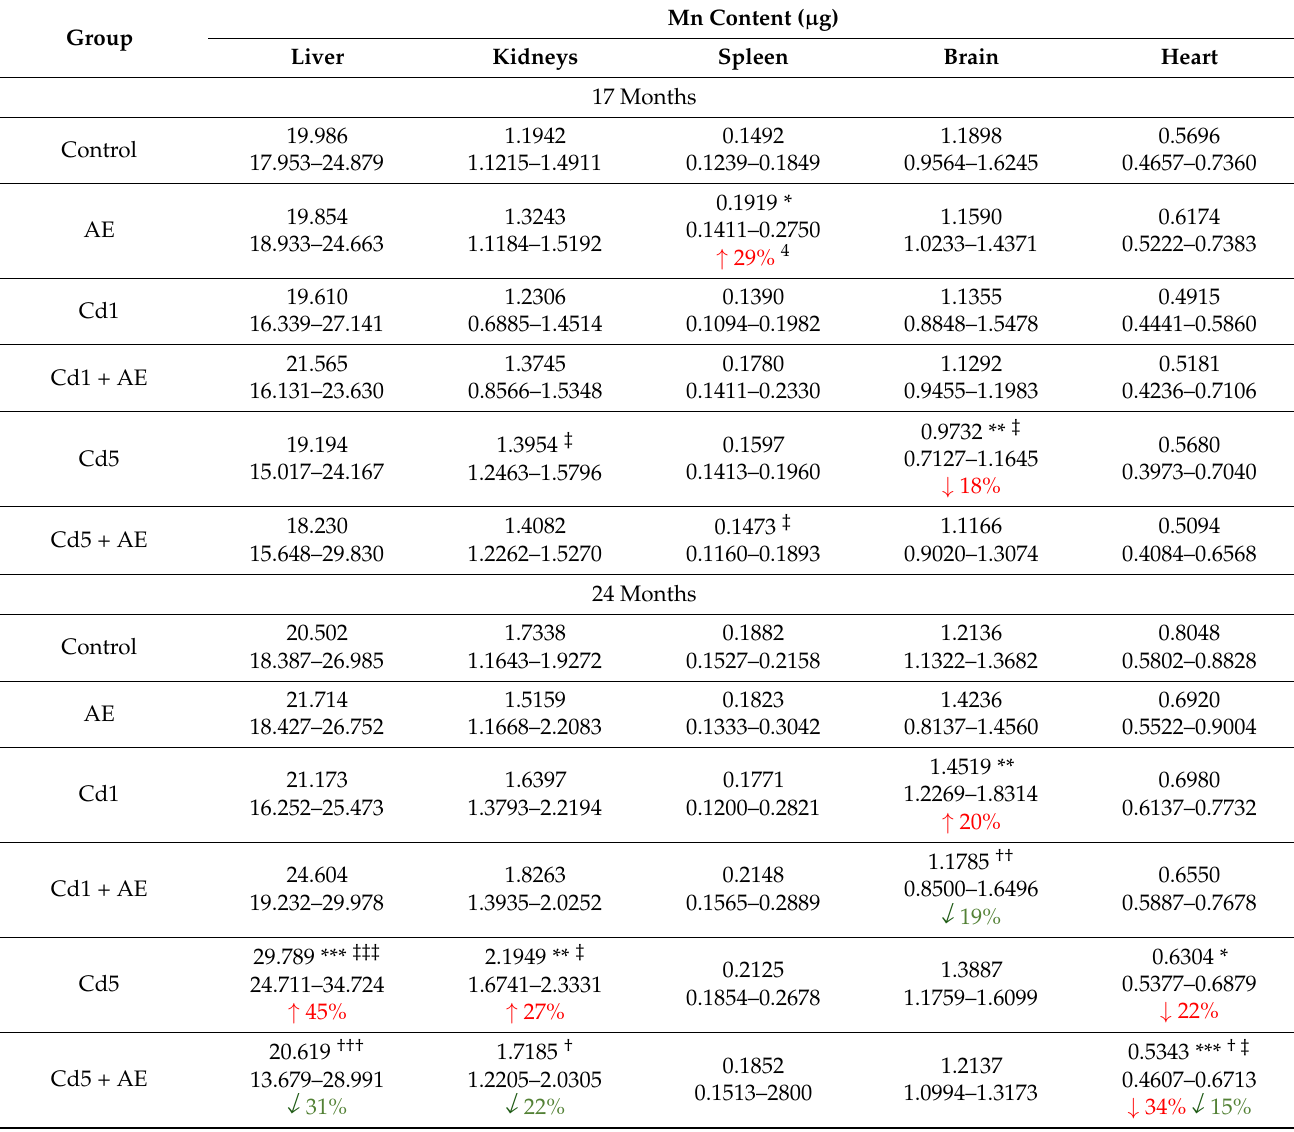
Table 4. The total content of Mn in the internal organs in particular experimental groups after 17 and 24 months of the study 3